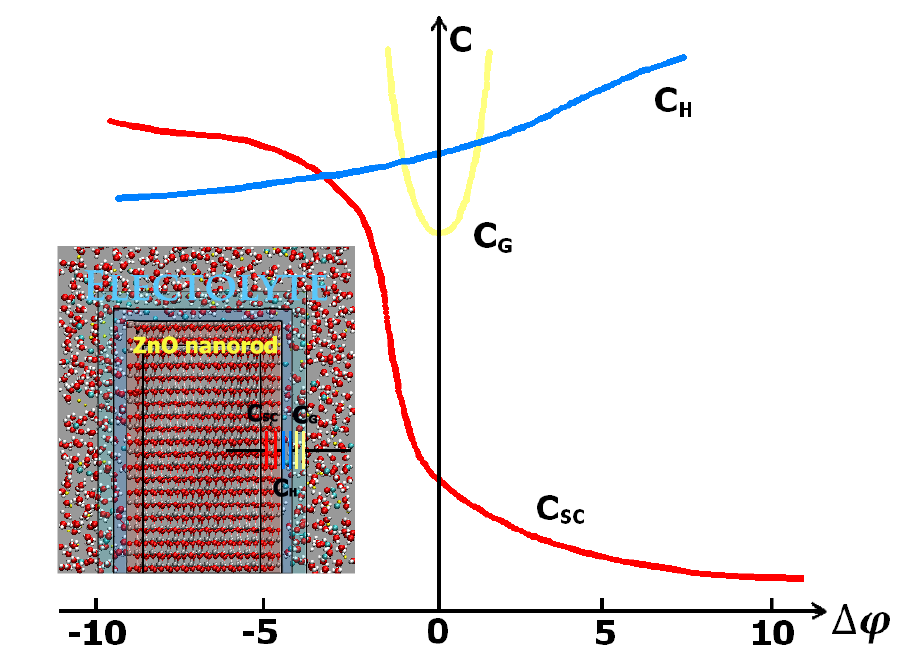
Figure 3. Potential dependence of the capacitance components of the n-type semiconductor-electrolyte